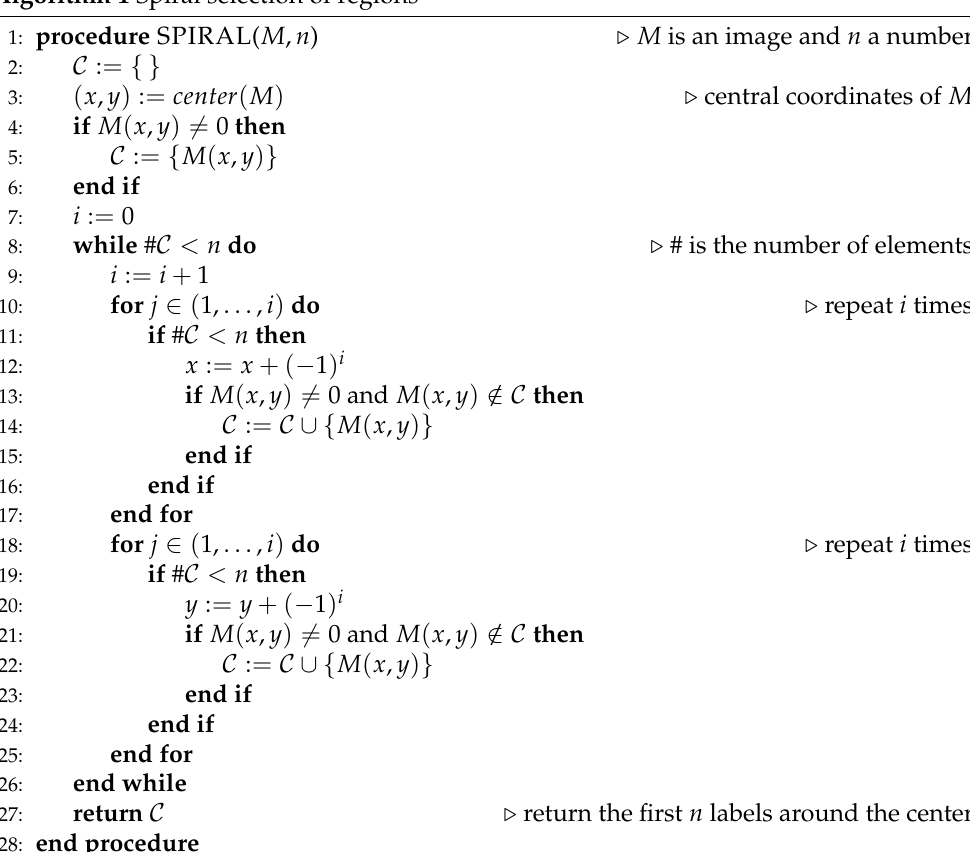
Algorithm 1 Spiral selection of